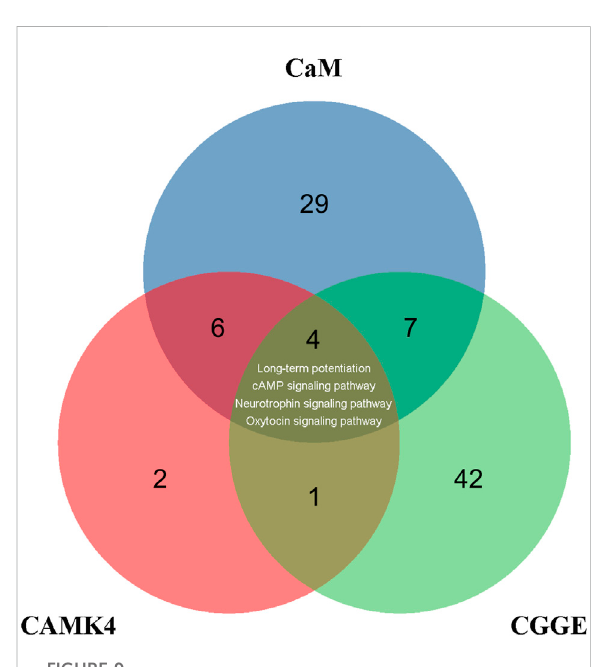
FIGURE 9 Venn diagram depicts the overlap of CaM, CAMK4, and CGGE-involved signaling pathways. Long-term potentiation, cAMP signaling pathway, and neurotrophin signaling pathway are related to the activation of